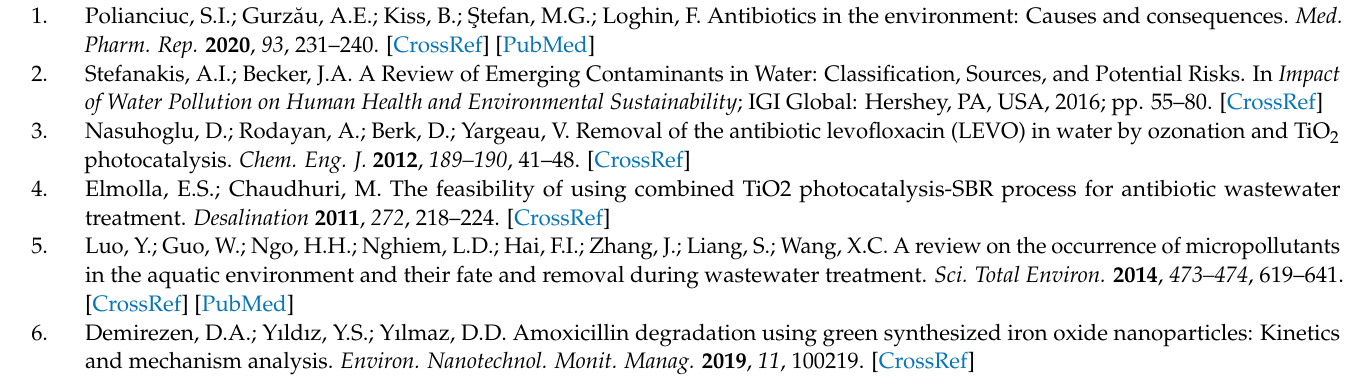
Figure S4. Visualization of water drop on static mixers with fillers: (from left to right) 3TiO 2